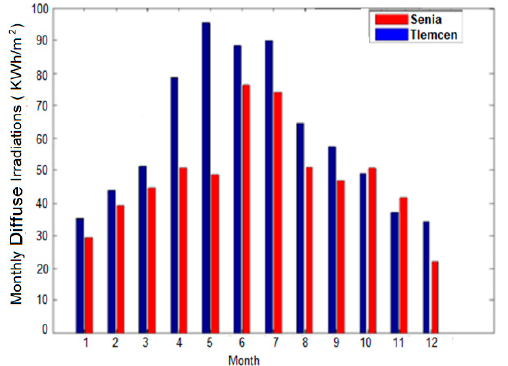
Figure 7. The distributions of the annual monthly average diffuse solar irradiation for both sites measured on a horizontal plane.